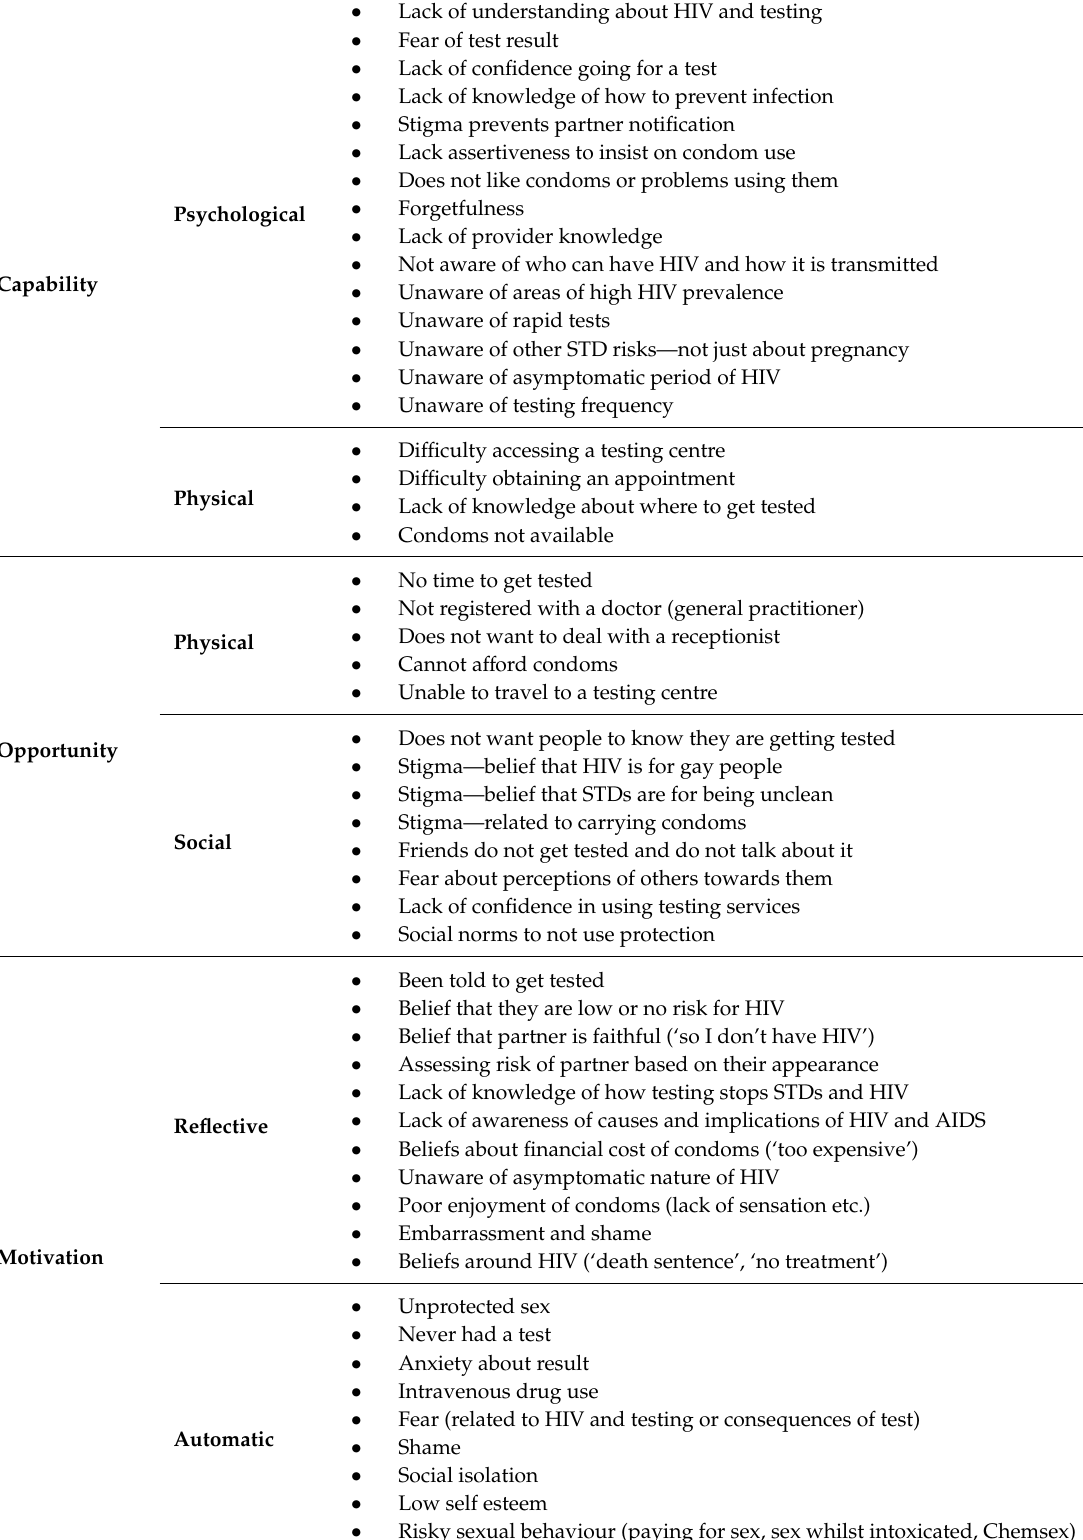
Table 1. Barriers to HIV testing and HIV prevention / risk behaviours mapped to the COM-B model.